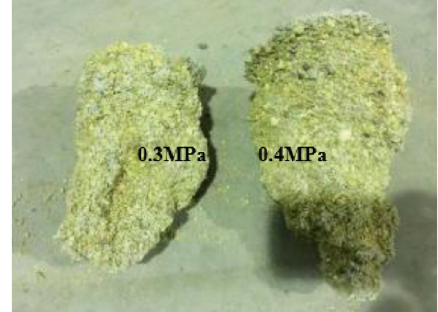
Figure 13: Concretion morphology.